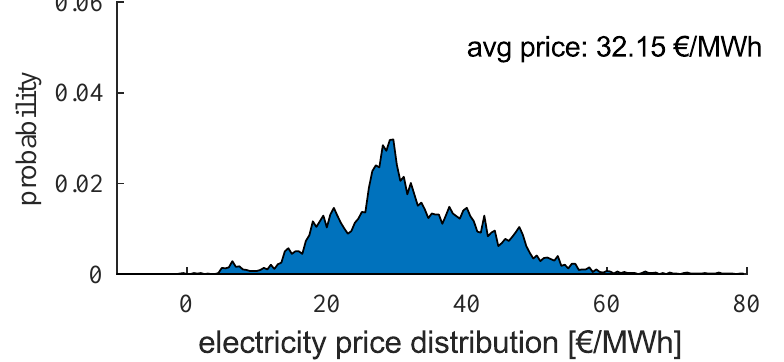
Figure 8. Simulated price distributions for Germany in 2014 using the EULR approach [23].